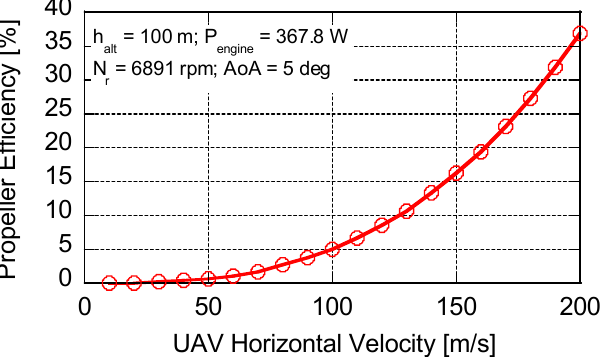
Figure 13. Required propeller efficiency to maintain flight at an AoA of 5 degrees.